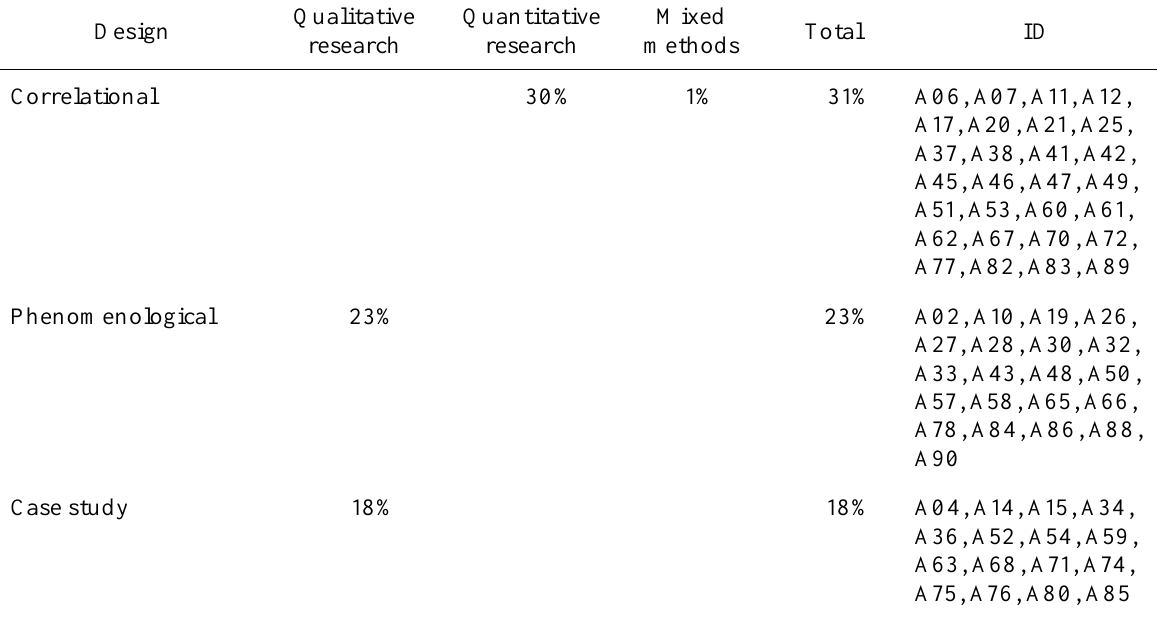
Classification by Design and Research